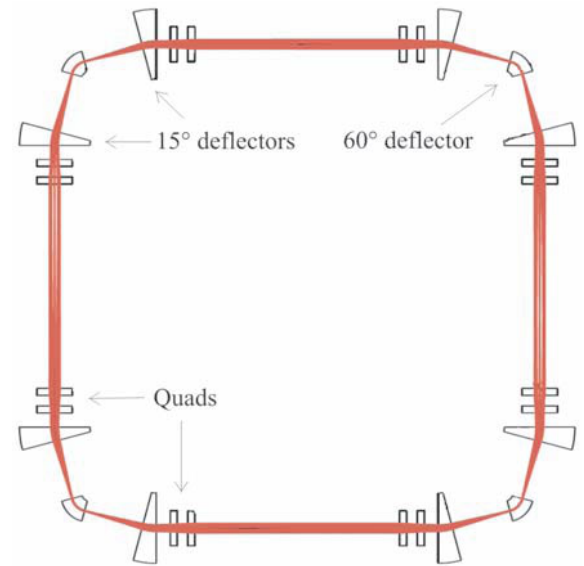
FIG. 1. (Color) Overview of the ring of FIRE.